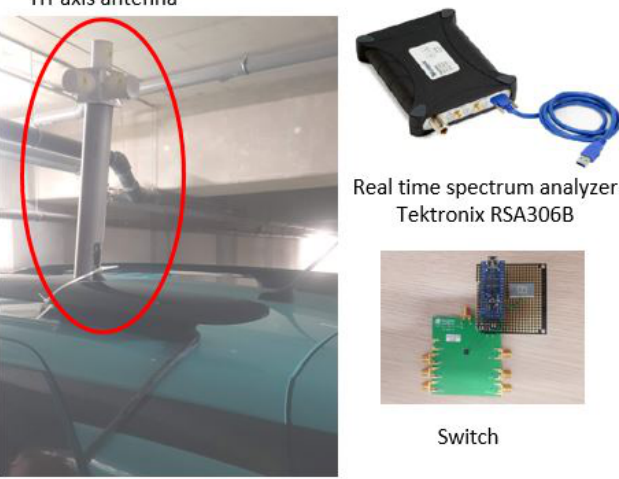
Figure 1. Measurement system: 3-axis antenna, Tektronix and switch.